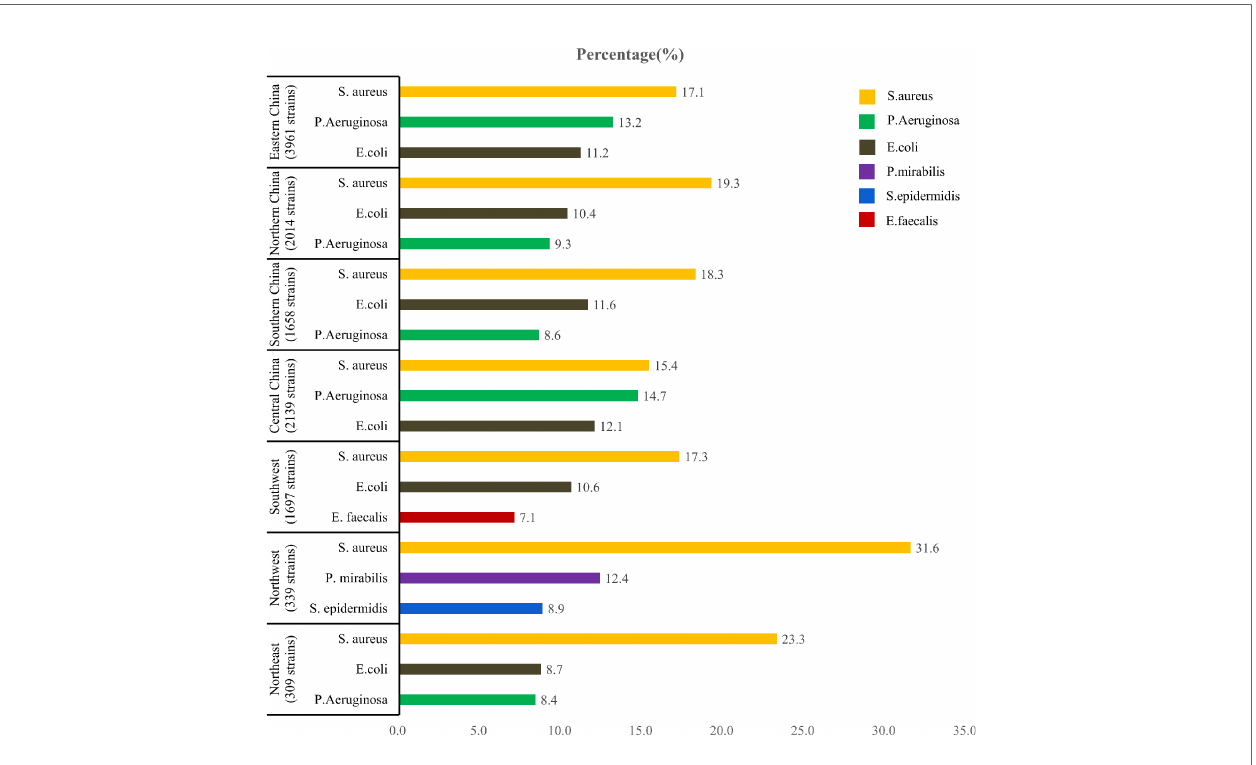
FIGURE 4 | Number of pathogens and main pathogens in different geographical regions of